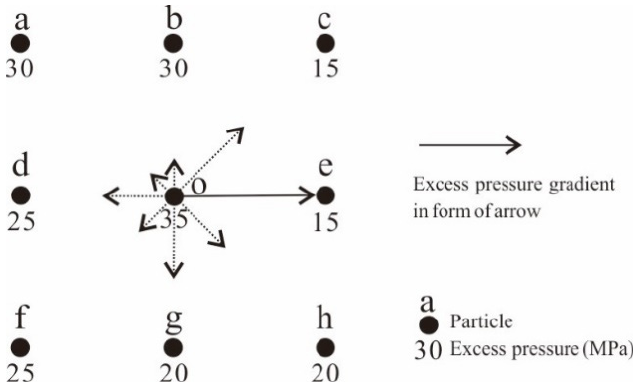
Figure 5. Sketch map of calculation about plane excess pressure gradient (The letters a–h represent different particles in the formation).